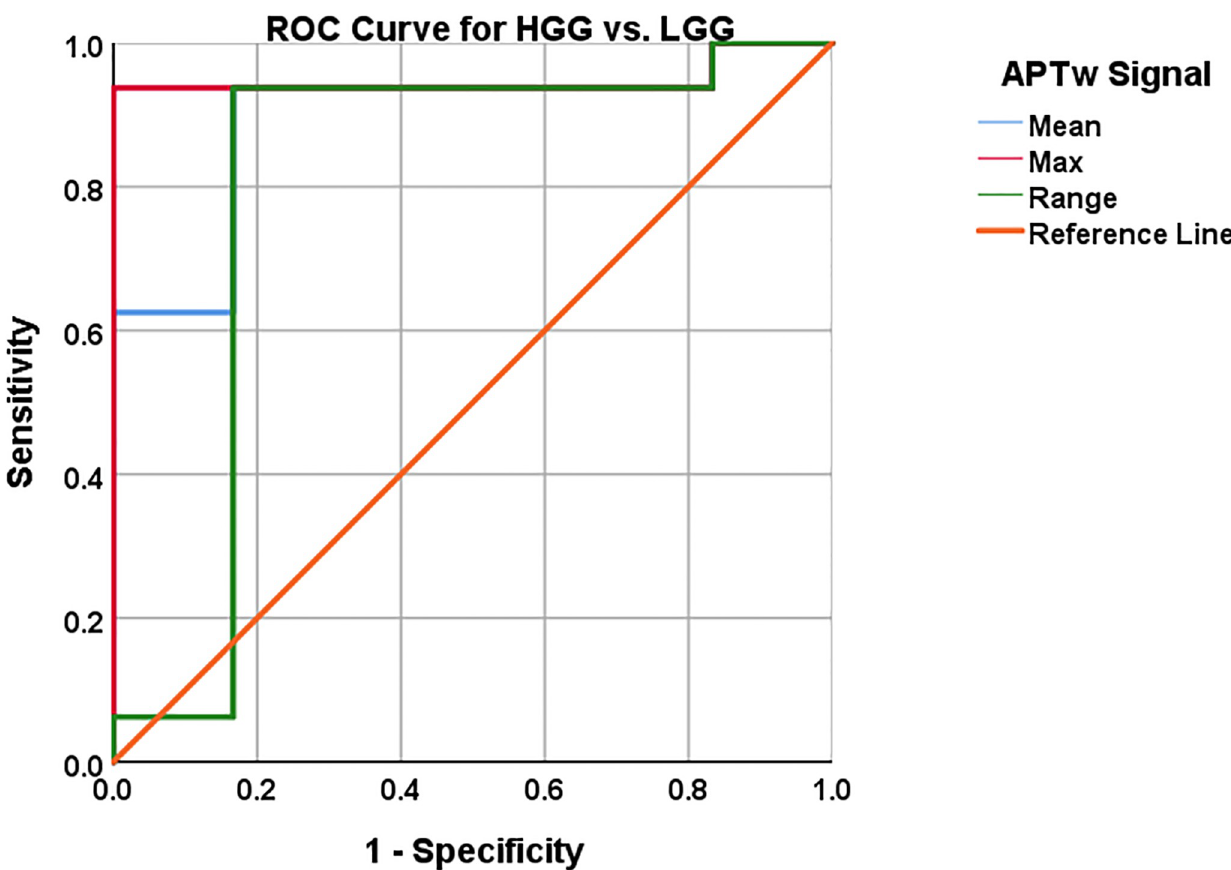
Fig 6. AUC, 95% CI, sensitivity and specificity with cut off values reported in Table 4.